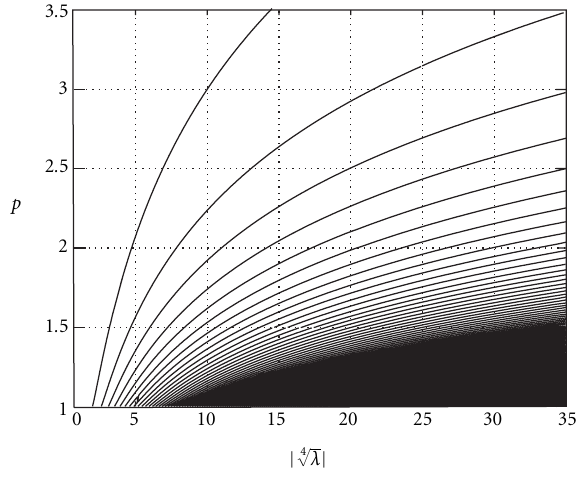
Figure 2.1. Spectrum of